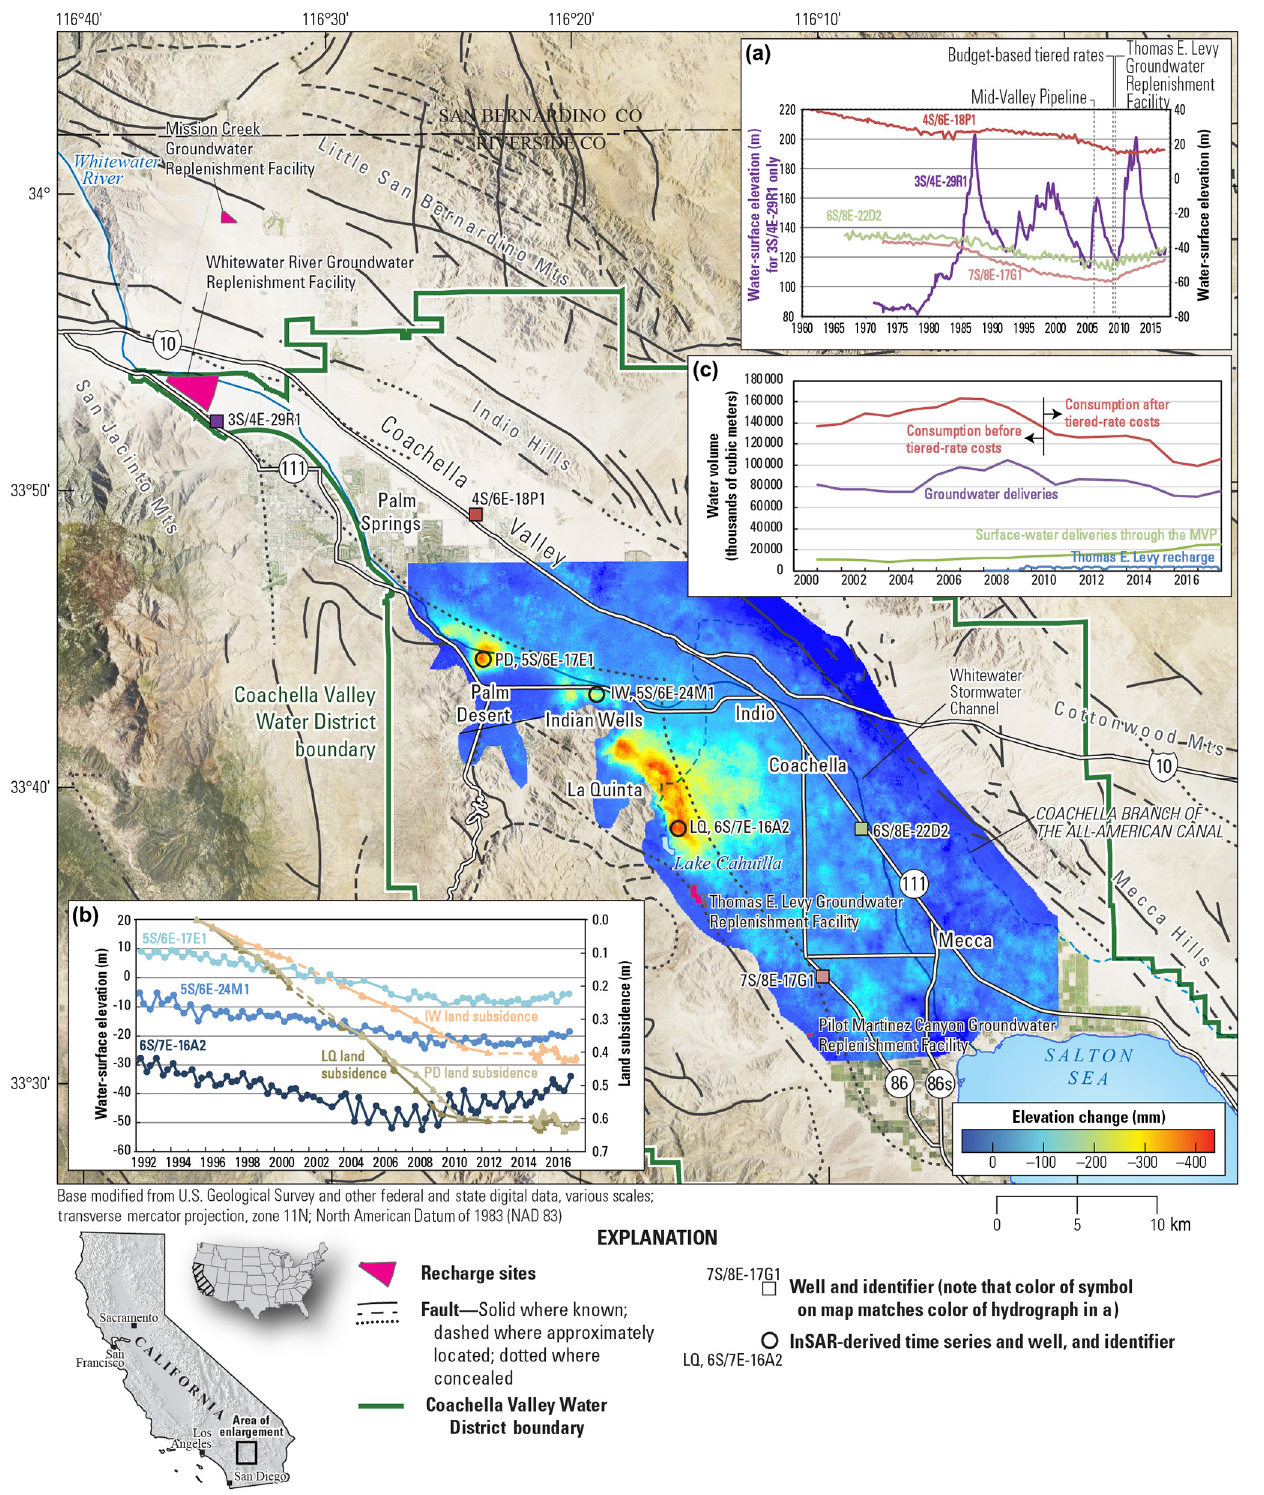
Figure 1. The Coachella Valley, California, USA with an interferogram showing land-surface deformation for 1995–2017 (excludes 8 November 2000–30 November 2003 and 19 September 2010–28 December 2014); (a) Groundwater levels in selected wells and mitigation strategies, 1960–2017; (b) InSAR-derived deformation at selected locations (dashed where estimated), and groundwater levels in selected wells, 1992–2017; (c) Water volumes for groundwater deliveries, surface-water deliveries through the Mid-Valley Pipeline, recharge at the Thomas E. Levy Groundwater Replenishment Facility, and consumption according to the implementation of tiered-rate costs,